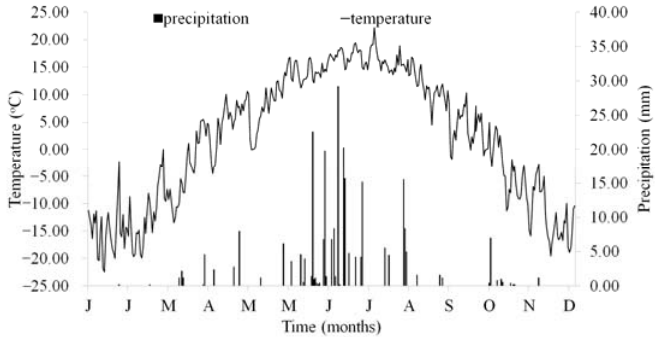
Figure 1. Seasonal dynamics of air temperature and precipitation during 1 year from January to December 2014 in Laotudingzi National Nature Reserve.